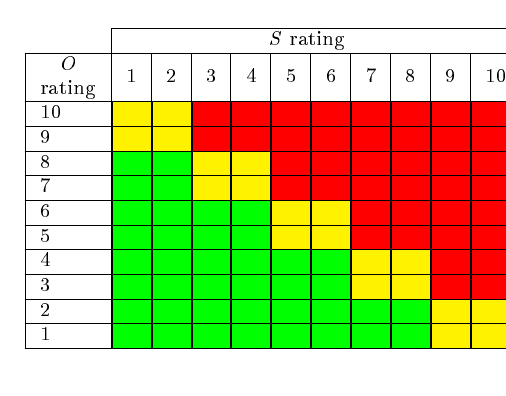
Tab. 9: Risk matrix